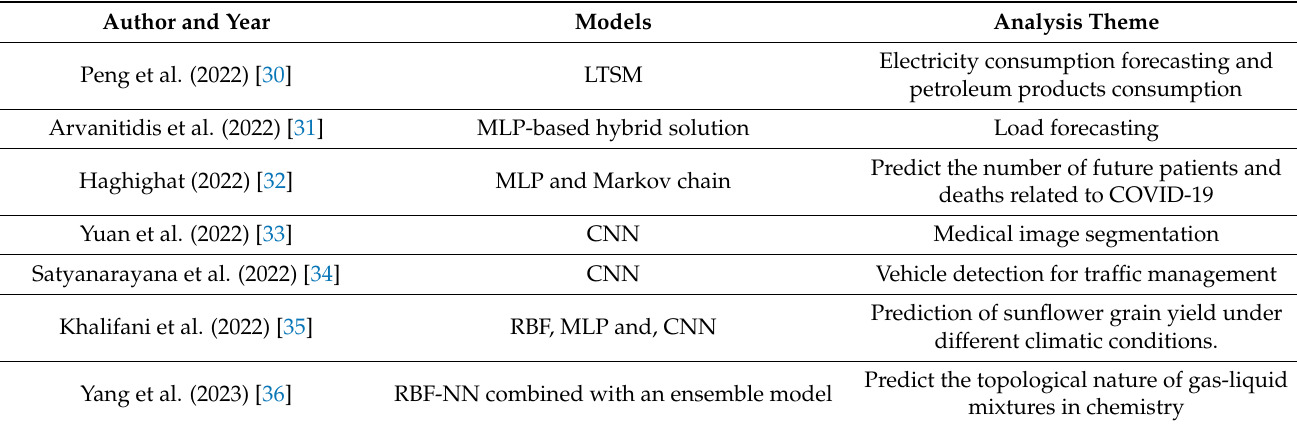
Table 1. Some recent applications of deep learning